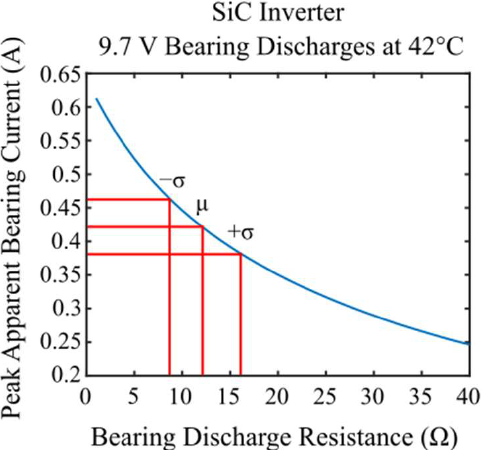
Figure 16. The normally distributed peak apparent bearing current is due to a normally distributed